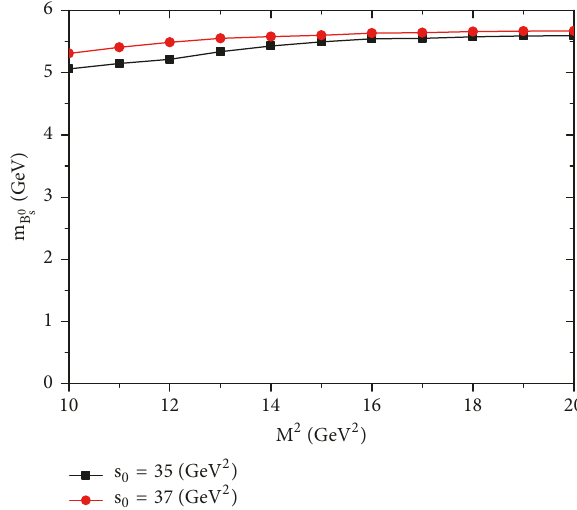
Figure 4: Borel parameter dependence of the 𝐵 0 푠